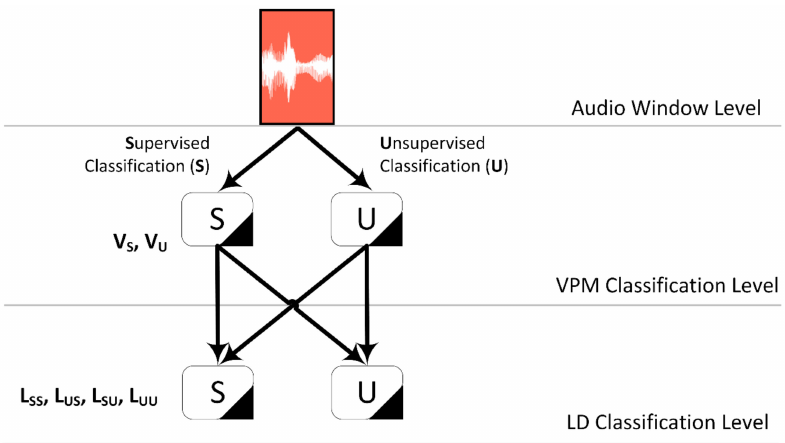
Figure 3. Configuration of the di ff erent classification paths, combining the two di ff erent classifiers (S, U) and the two taxonomy levels (VPM,